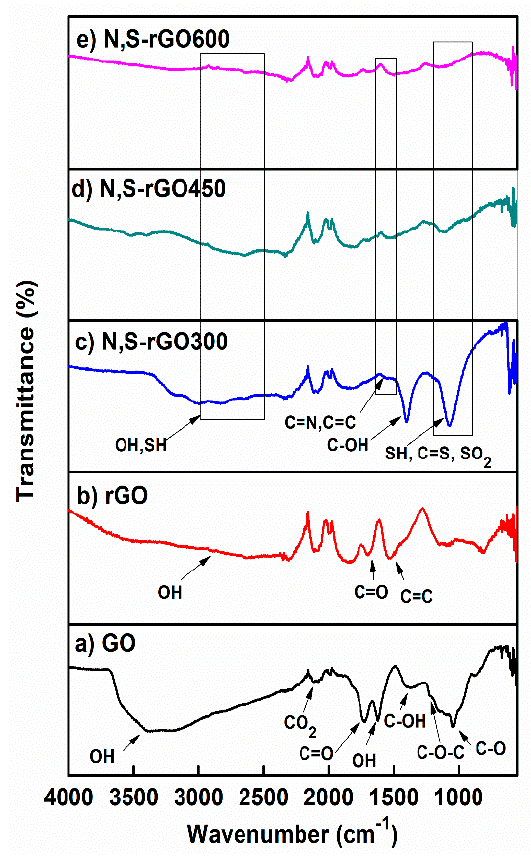
Figure 1. Fourier Transform Infrared Spectroscopy (FTIR) spectra for precursors of coatings. ( a ) GO, ( b ) rGO, ( c ) N,S-rGO300 ( d ) N,S-rGO450 ( e ) N,S-rGO600.